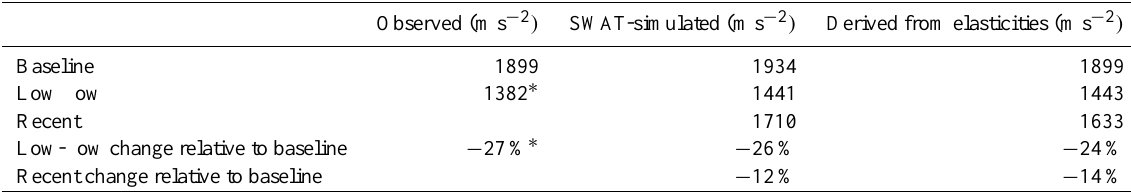
Table 3. Mean annual streamflows estimated from the SWAT model and derived from the runoff elasticities in the baseline (1960–1990), low-flow (1991–2002), and recent (2003–2011) periods.